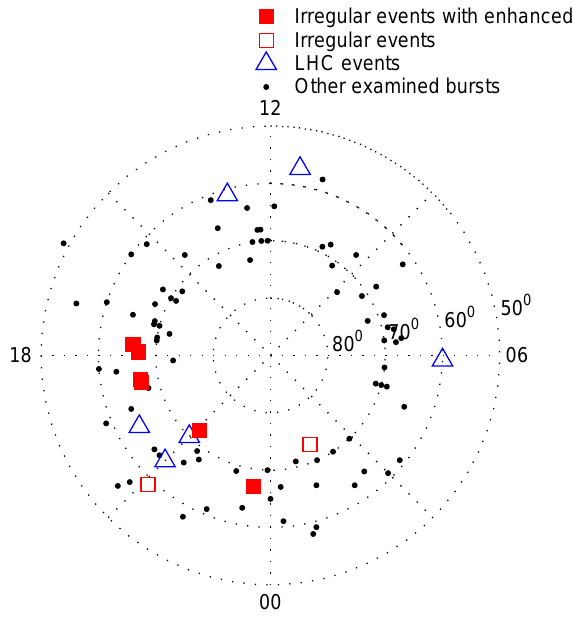
Fig. 8. View over the Northern Hemisphere. The time is given in MLT and the circles indicate the latitude. Due to the 63 ◦ inclination of the Freja orbit we do not measure above 75 ◦ . Irregular density variation events are marked by squares. The filled squares indicate where events with enhanced magnetic wave activity have been found. Triangles denote LHC events, while dots mean that no density variations are detected. Event 1, which includes both irregular density variations and LHCs, is marked by a filled square.